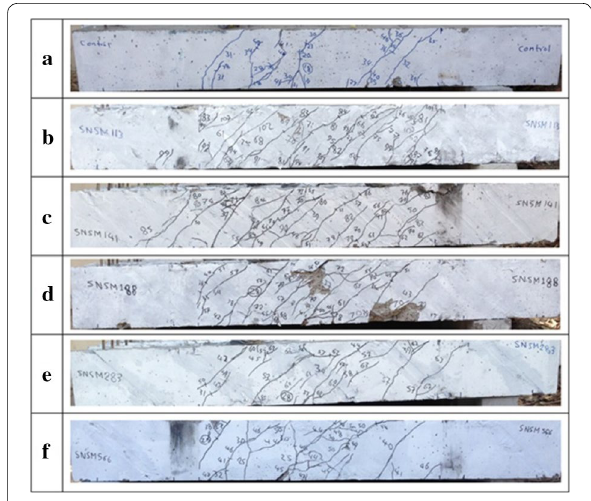
Fig. 13 Failure modes of specimens under combined torsion and bending: a control specimen, b SNSM113, c SNSM141, d SNSM188, e SNSM283 and f SNSM566.